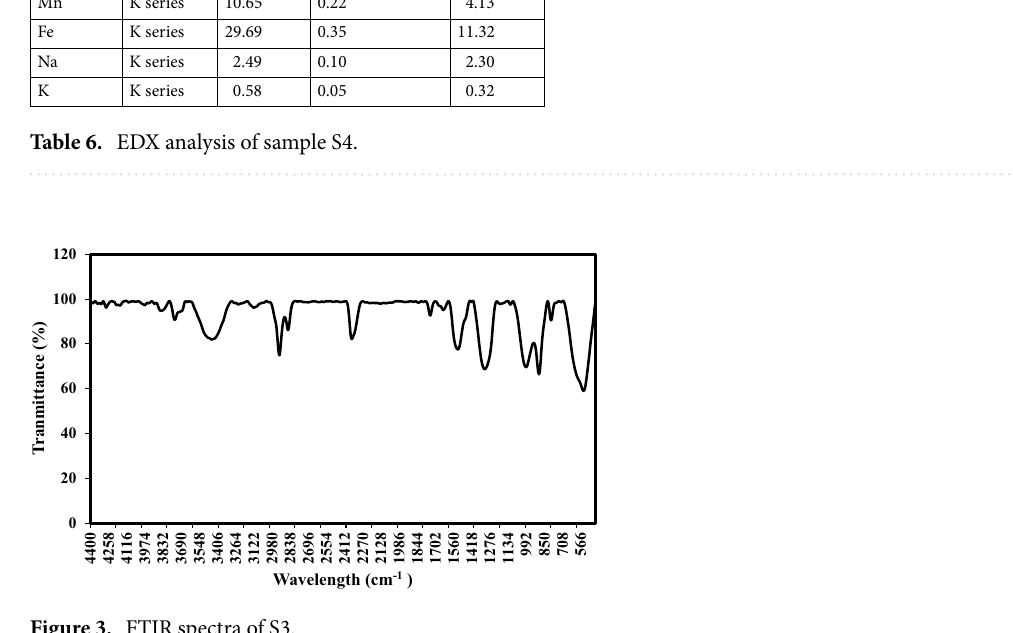
Figure 3. FTIR spectra of